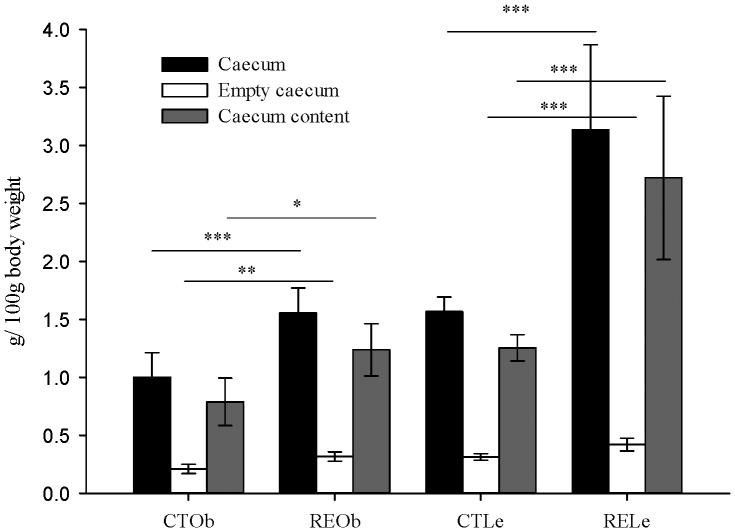
Effect of the RE-supplementation on full caecum, empty caecum and caecum content weight.Obese (Ob) and lean (Le) female Zucker rats were fed a control diet (CT) or the diet supplemented with the rosemary extract (RE) enriched in carnosic acid (CA ∼40%). Values are expressed as g/100 g of body weight. Bars indicate mean values ± SD (n = 7 lean animals, n = 5 obese animals per group). Significant differences between control and RE-supplemented groups are also indicated: *P<0.05, **P<0.01, ***P<0.001.